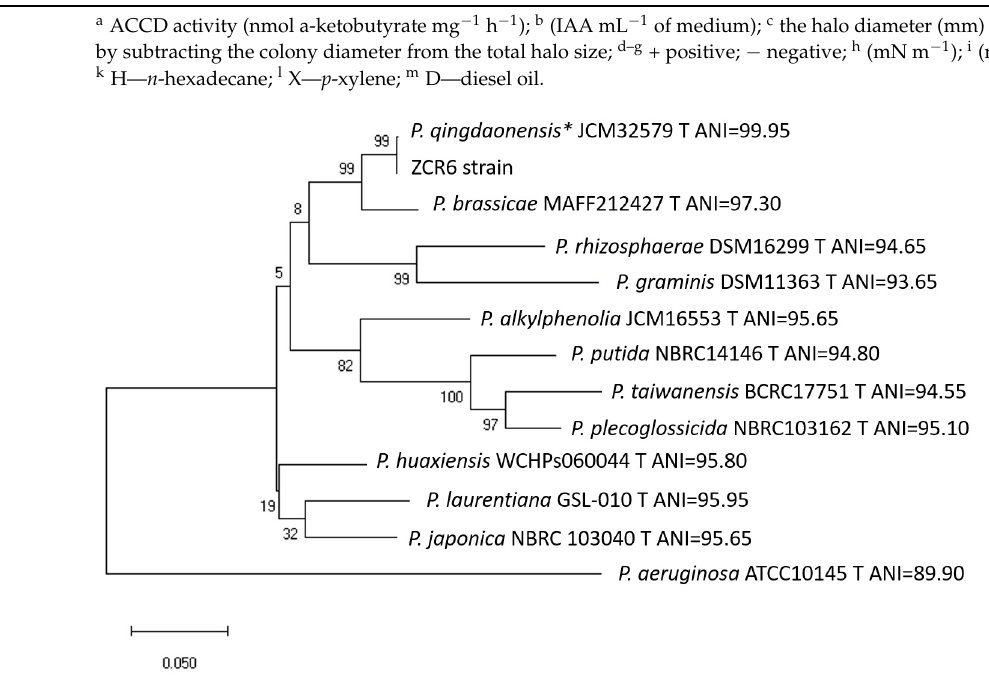
Figure 1. Maximum-likelihood-based phylogeny resulting from the concatenated 16S rRNA, gyrB , and rpoD sequences, representing the relative position of the ZCR6 strain among other Pseudomonas . All positions containing gaps or missing data were eliminated. The final dataset contained 2563 positions. Accession numbers of sequences used in this study are listed in Supplementary Table S1. Bootstrap values are represented at the branching points. The bar represents 0.05 substitutions per site. Each strain is given an ANI value relative to the sequences belonging to the ZCR6 strain; * strain JJ3 T with the highest ANI